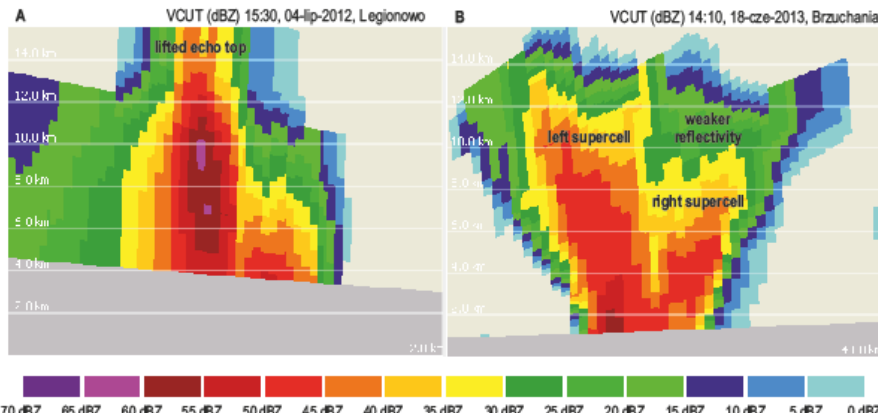
Fig. 2. Examples of the vertical reflectivity distribution with the uncertainties. A - Vertical cross-section through the supercell storm with hailstones of 7 cm in diameter in northern Poland. July 4, 2012 radar Legionowo B - Vertical cross-section through the supercell storms during the splitting process. June 18, 2013 Kielce area, radar